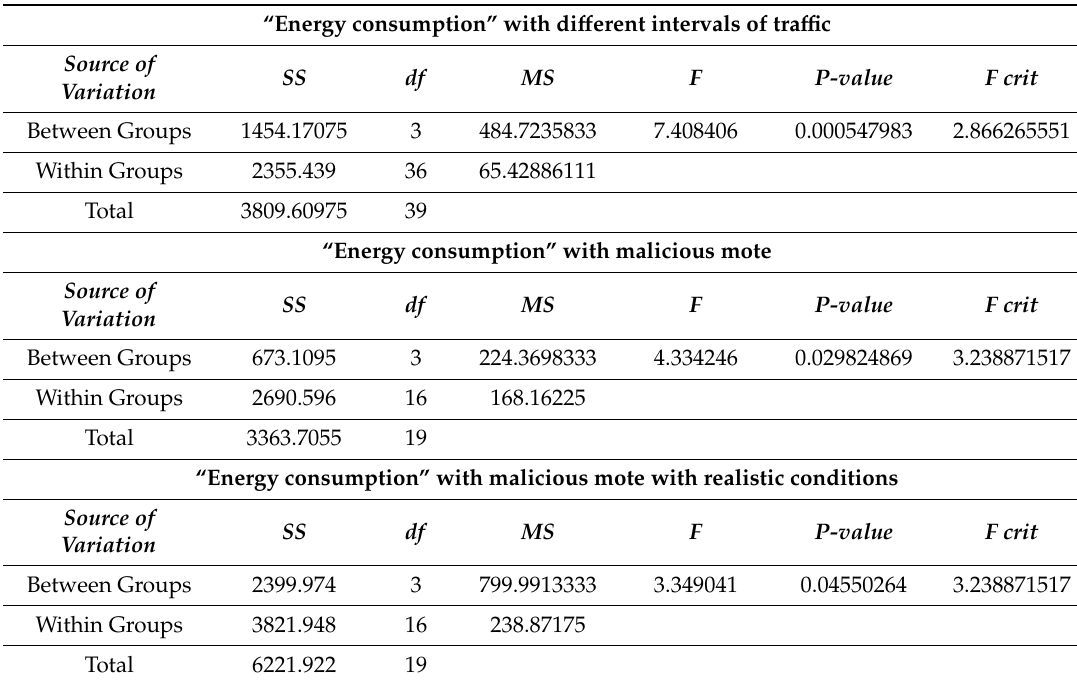
Table 3. ANOVA statistics of the proposed QCM algorithm in terms of energy consumption